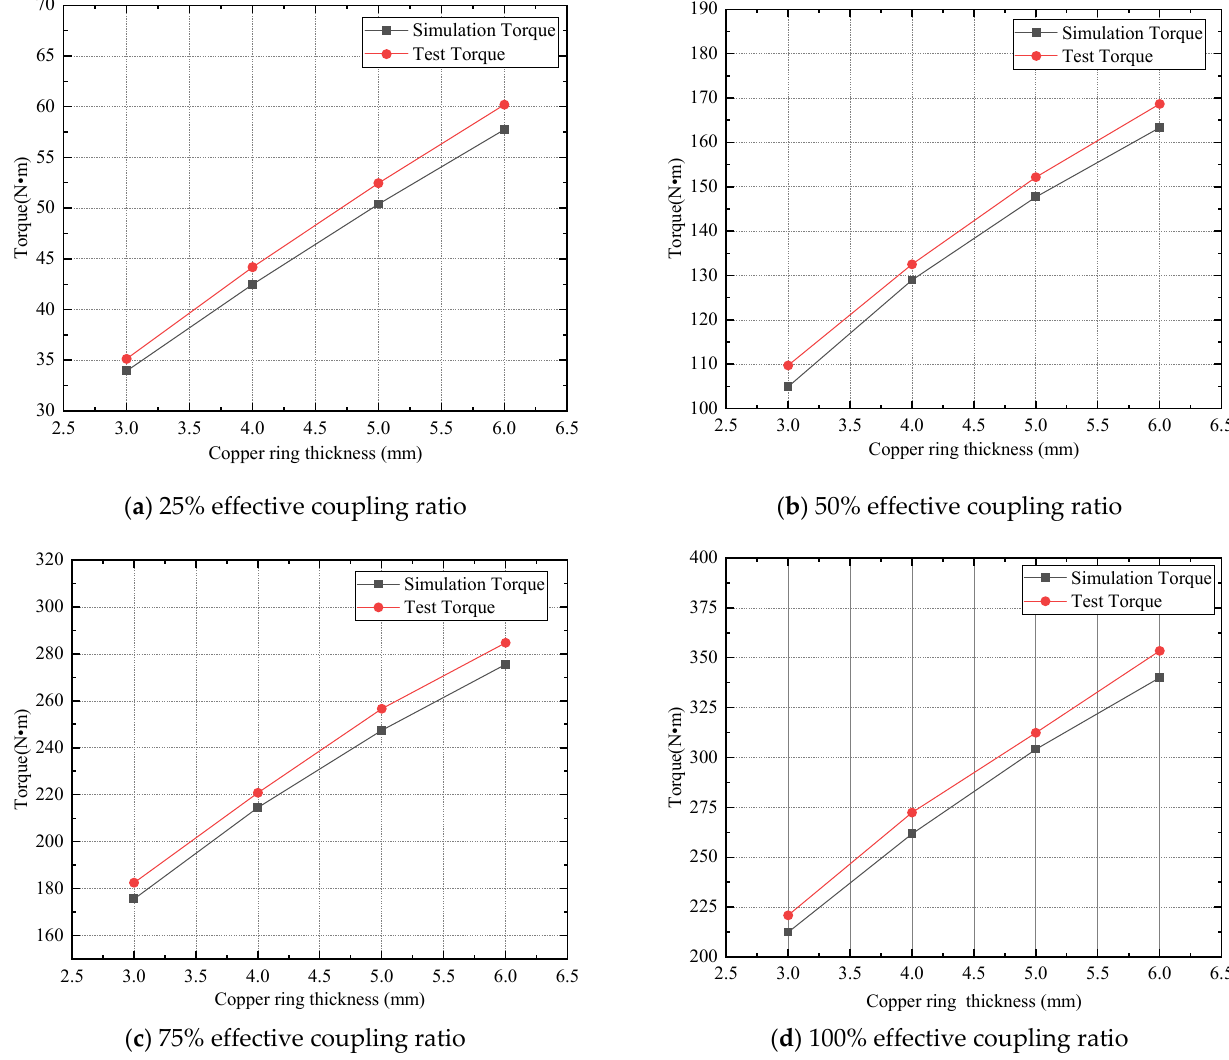
Figure 18. Output torque simulation and test comparison under different thicknesses. Table 5. Comparison of experimental and simulation results of output torque under different cop- per ring thicknesses.